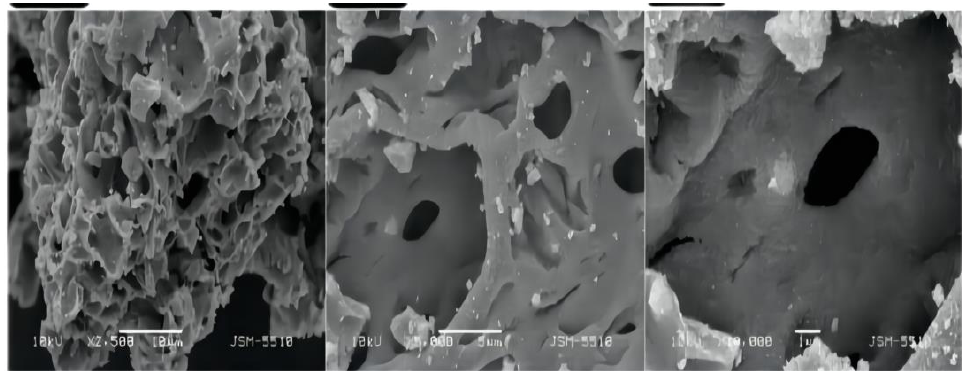
Figure 6. Morphology of zinc oxide afterAu composite.